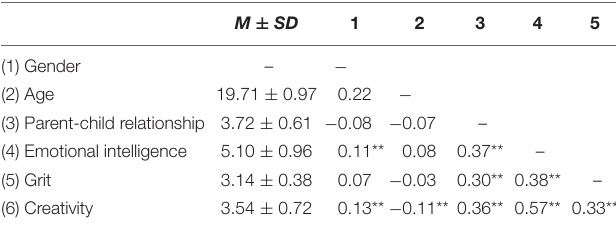
TABLE 1 | Correlation coefficients, means, and standard deviations of variables ( n = 663). M ±